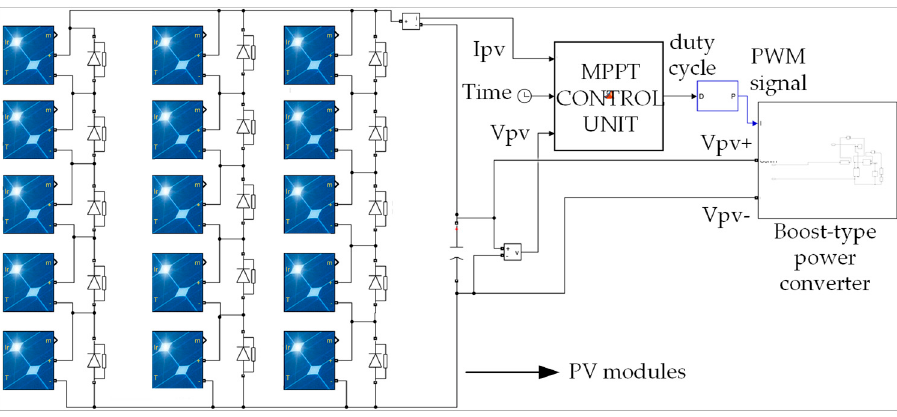
Figure 5. The model of the PV system under study in MATLAB TM /Simulink.